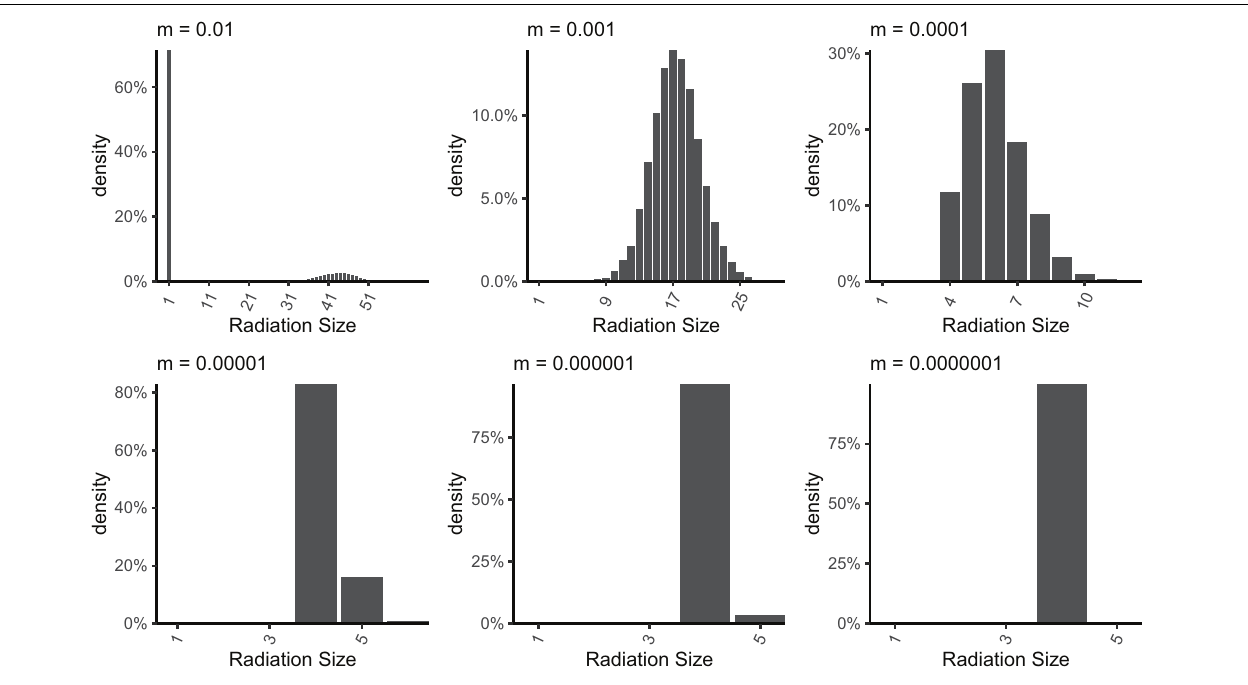
FIGURE 5 | Radiation size distributions across repeat simulations for a single immigrating lineage under different rates of internal dispersal (m). The numbers given above each panel indicate the internal dispersal rate (m). The habitat network simulated was a line structure with 4 patches, each having 1000 individuals. Gene flow effect (G) was 0.1.